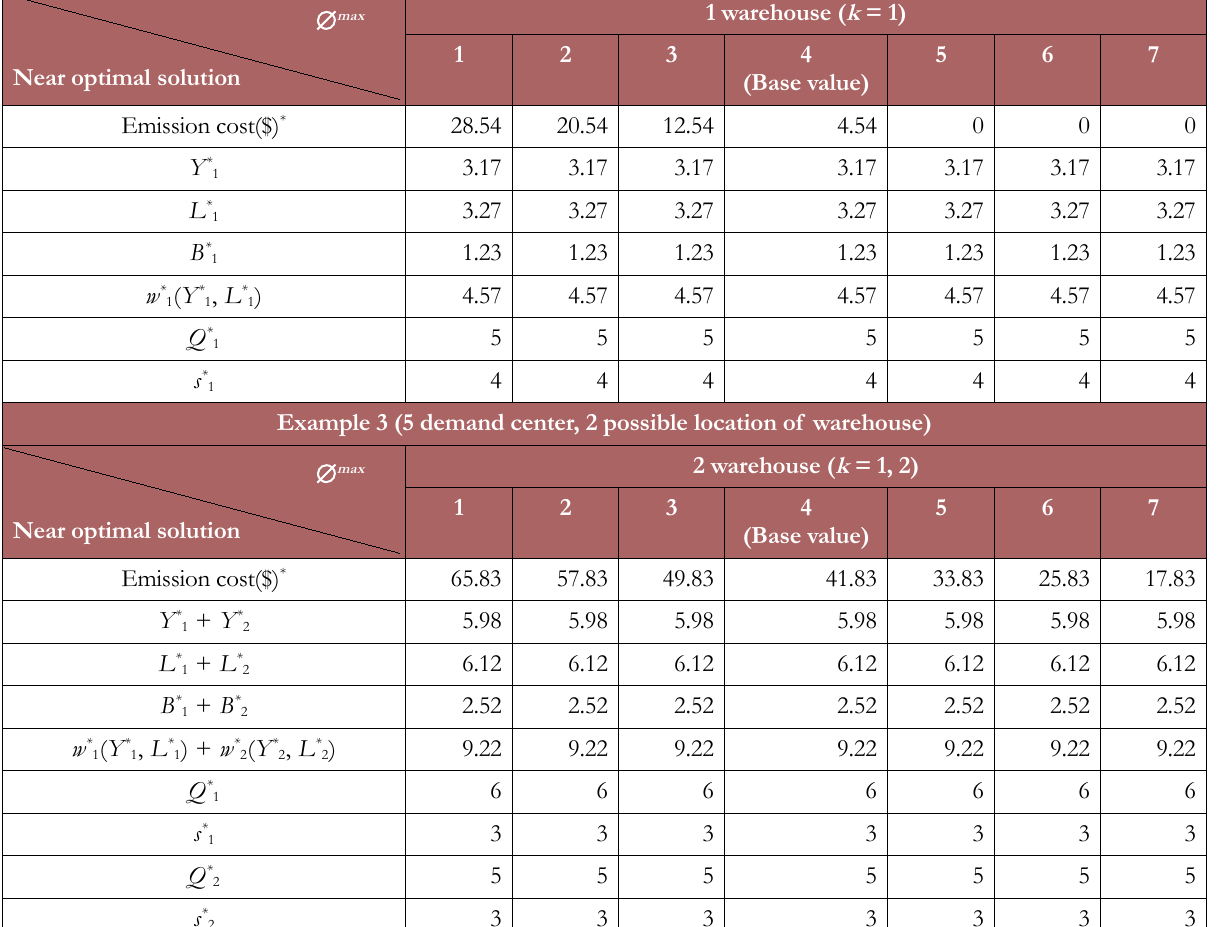
Table 7. Impact of the emission